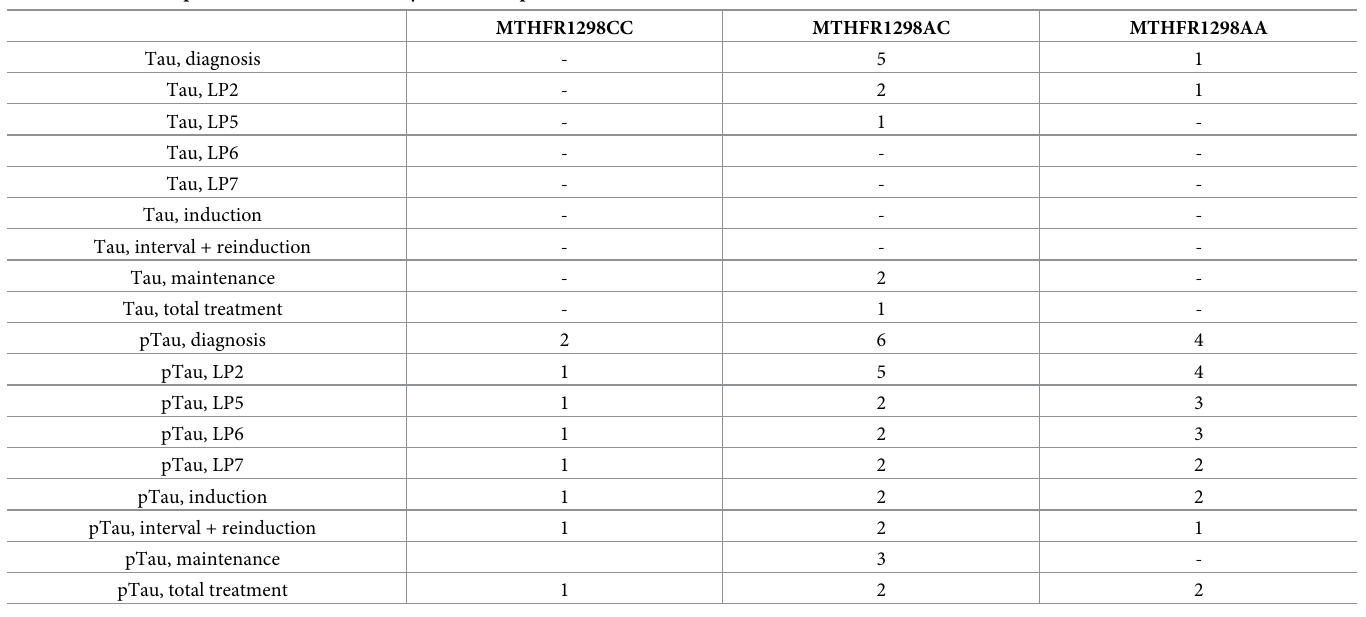
Table 2. Some of the patient dossiers in this study were